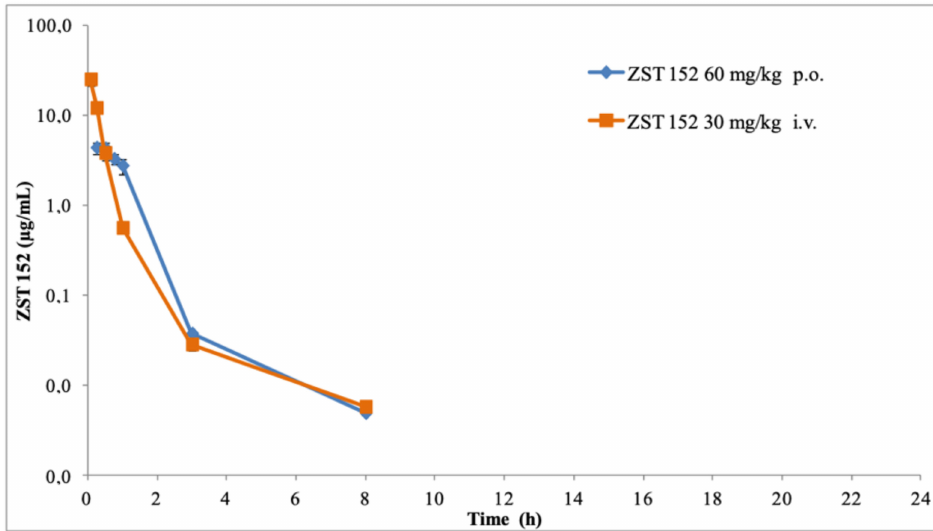
Figure 6. Plasma decay curves of ZST152 after single oral and intravenous